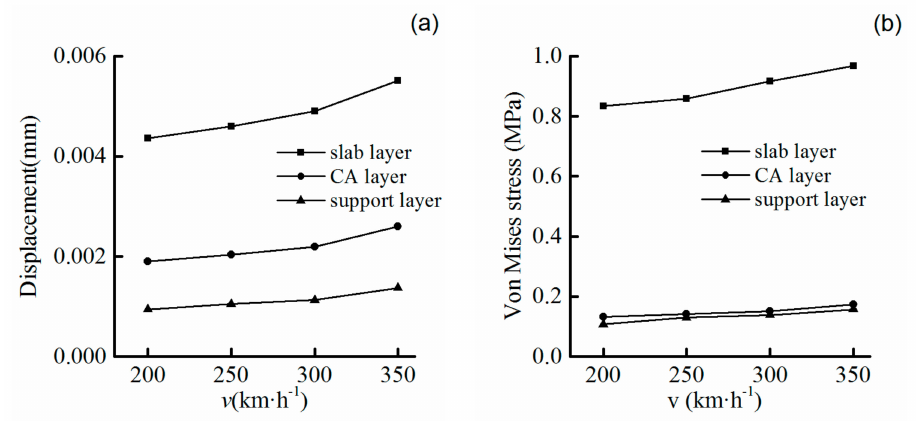
Figure 15. E ff ects of running speed on the dynamic behavior of supporting track components: ( a ) vibration displacement versus running speed and ( b ) von Mises equivalent stress versus running